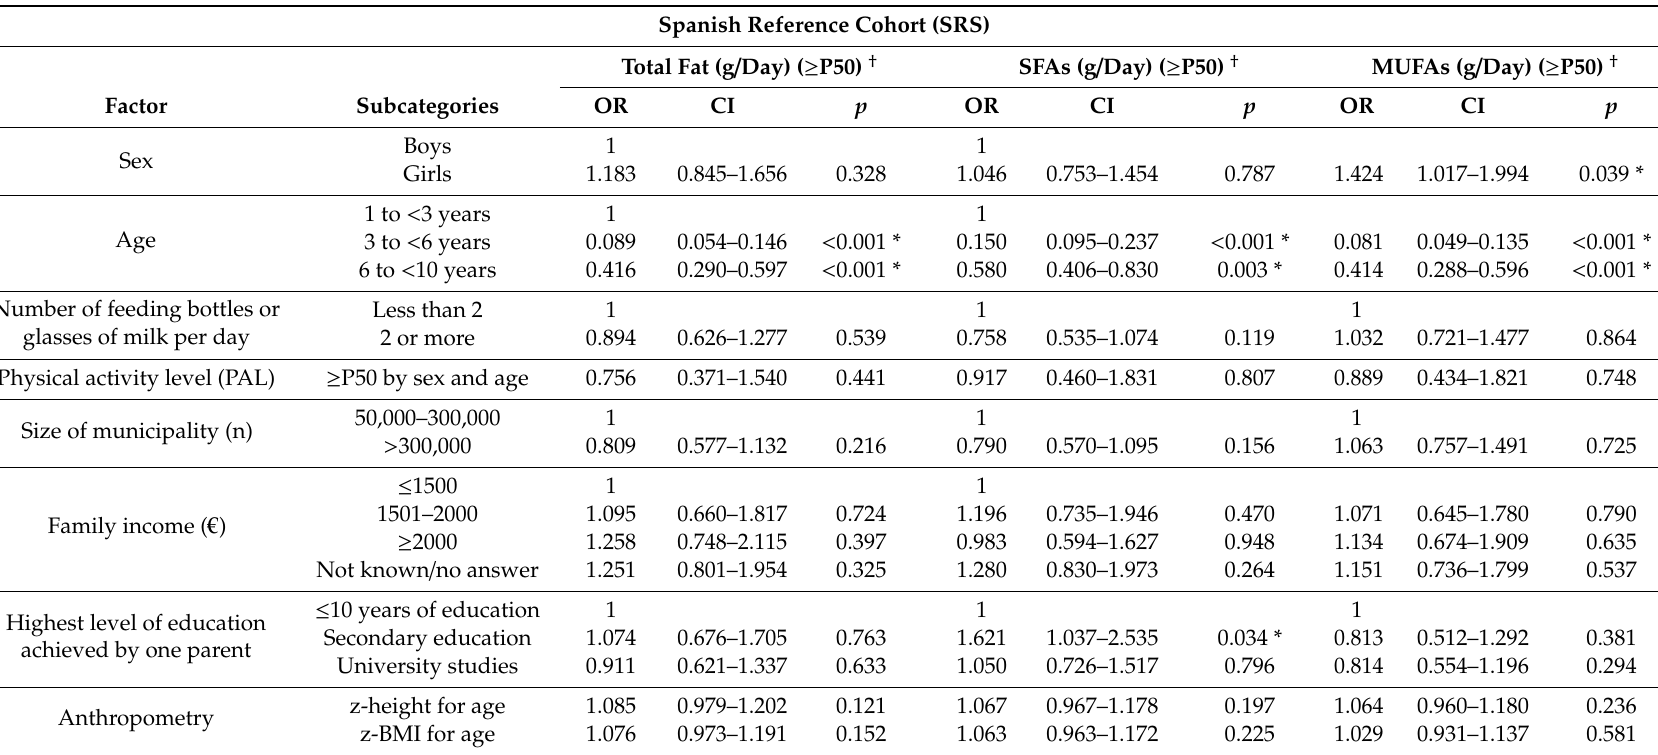
Table 9. Odds ratios (OR) and 95% confidence intervals (CI) for intake equal to or higher than the median of fat, saturated fatty acids, and monounsaturated fatty acids relative to family and personal factors in the reference cohort of the Nutritional Study in the Spanish Pediatric Population (EsNuPI) ( n =